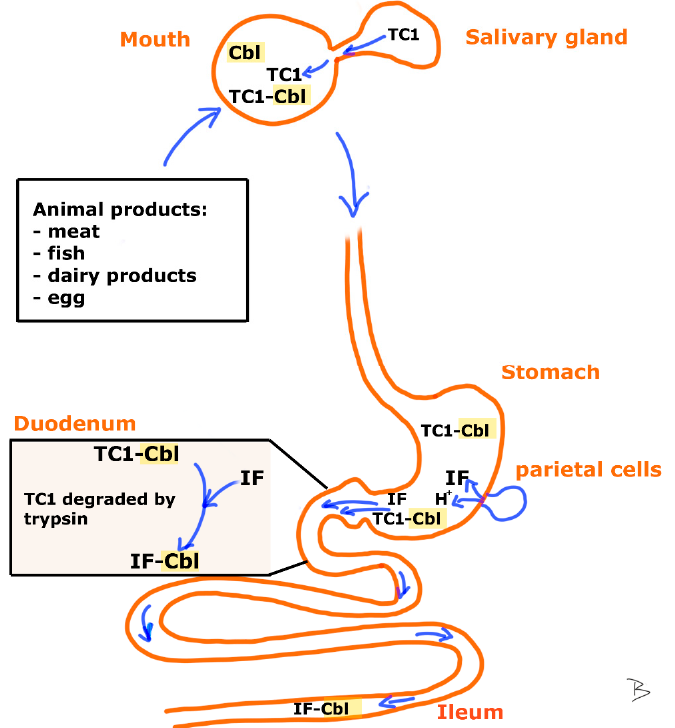
Figure 1. Route of Cbl from intake to the place of absorption. Dietary Cbl is anchored to the protein transcobalamin-1 (TC1, suggested terminology according to Uniprot search term: P20061 or TCO1_HUMAN, common used name: haptocorrin [8]) either in the mouth (TC1 of salivary gland origin) or already before ingestion, since human breastmilk contains TC1 bound Cbl (TC1-Cbl). Attachment to this protein prevents the damage of the cofactor at the acidic pH of the stomach. In the duodenal lumen pancreatic trypsin partially degrades TC1. Though secreted by the parietal cells of the stomach, intrinsic factor (IF) is only bound to Cbl in the duodenum, after it is released from TC1. Among factors affecting IF synthesis are gastrin, acetylcholine and histamine. The newly formed IF-Cbl complex is transported to the ileum where the apical membrane of the intestinal epithelial cells of the brush-border incorporates it via receptor mediated endocytosis.